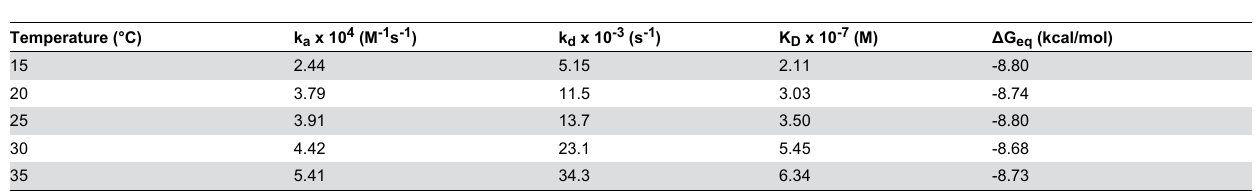
Table 3. Affinity of mAb 6C6D7 to K-tritrpticin at different temperatures obtained by SPR based binding assays.